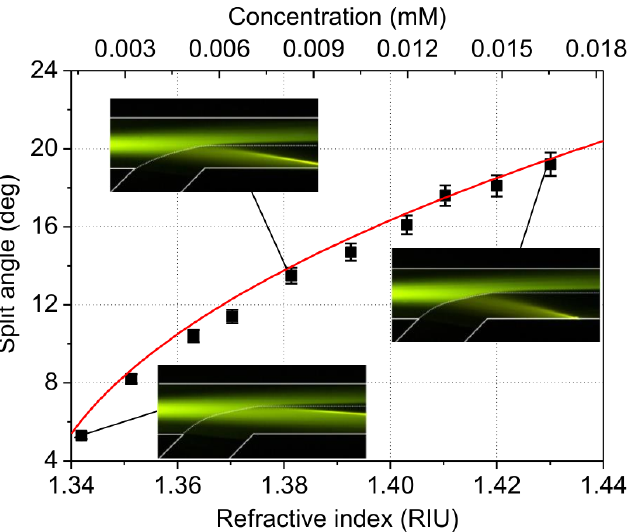
Figure 4. Split angles for given concentrations of ethylene glycol solutions in experiments. The squares are experimental data, solid line is theoretical prediction.